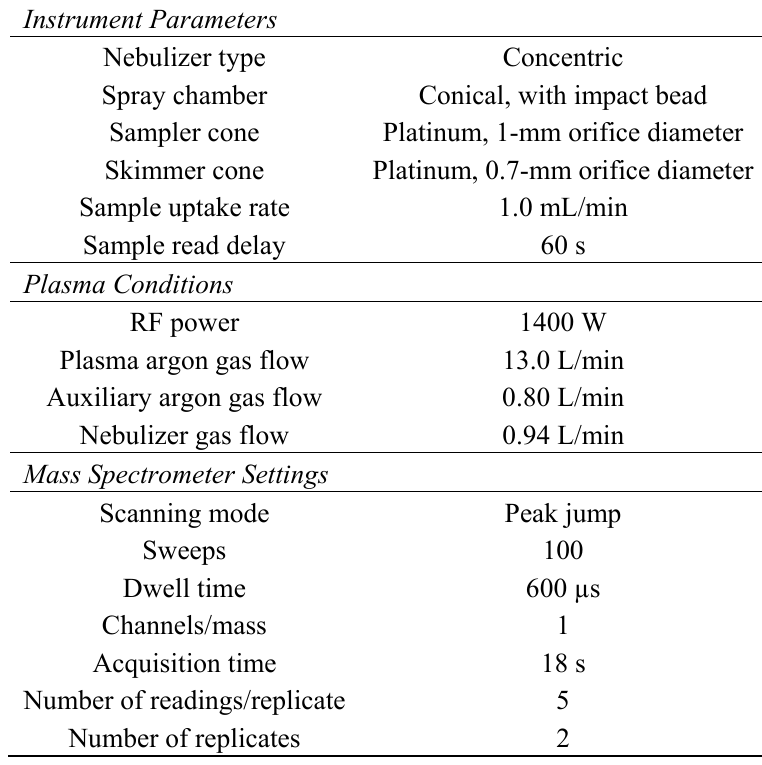
Table 4. ICP-MS operating conditions and